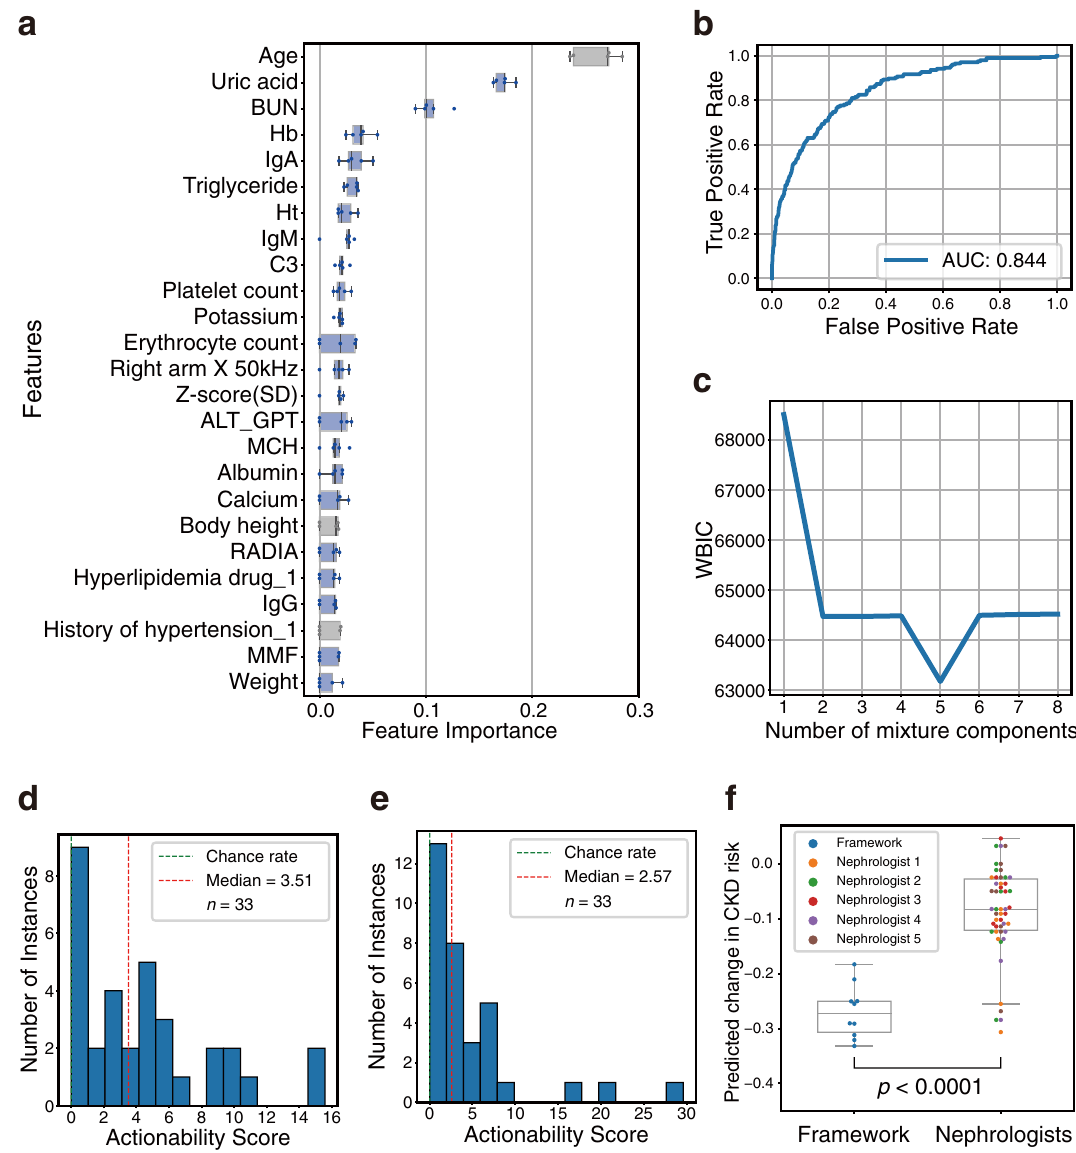
Fig. 7 Application of proposed framework on chronic kidney disease (CKD) risk classi fi cation task using the Iwaki health promotion project (IHPP) dataset. a Feature importance: these 25 features were selected by recursive feature elimination (RFE) to predict the estimated glomerular fi ltration rate (eGFR) category. RFE was performed with fi ve-fold cross-validation, and the feature importance when 25 variables remained is shown for each fold ( n = 5). The plot color represents the following: gray: variables which cannot be intervened, and blue: intervenable variables. Details of features are described